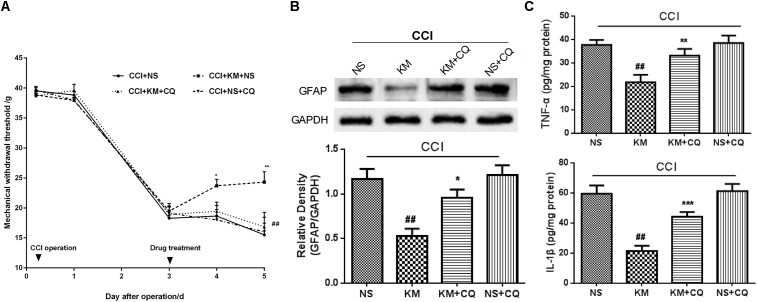
Blockage of autophagy activity diminished effect of koumine (KM) on MWT and astrocyte activation in CCI rats. (A) The antagonistic effect of chloroquine (CQ) against antinociceptive effect of koumine. Data indicate the withdrawal threshold for the ipsilateral paw as the mean ± SEM (n = 5–7 per group). ∗P < 0.05 and ∗∗P < 0.01 compared with the CCI+NS group. ##P < 0.01 compared with the versus CCI+KM+NS group, two-way repeated-measures ANOVA followed by LSD or Dunnett’s T3 test for each time point. (B) GFAP level was detected by Western blot in the spinal cord. (C) Pro-inflammatory cytokine IL-1β and TNF-α in spinal cord of CCI rats after the koumine (KM) and CQ administered. Data are expressed as the mean ± SEM. ##P < 0.01 versus CCI+NS group. ∗P < 0.05, ∗∗P < 0.01, and ∗∗∗P < 0.001 versus CCI+KM group, separate one-way ANOVA followed by LSD test.